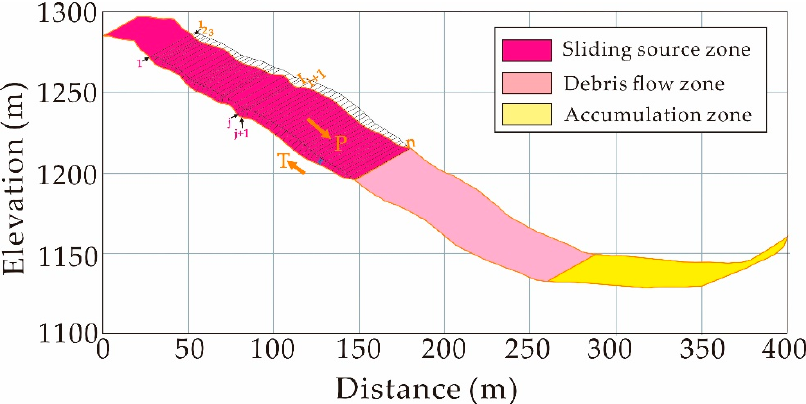
Figure 6. The 3D numerical DAN-W model of the landslide. The parameters are the same as in Equations (1)–(7) (It is modified from [23]).